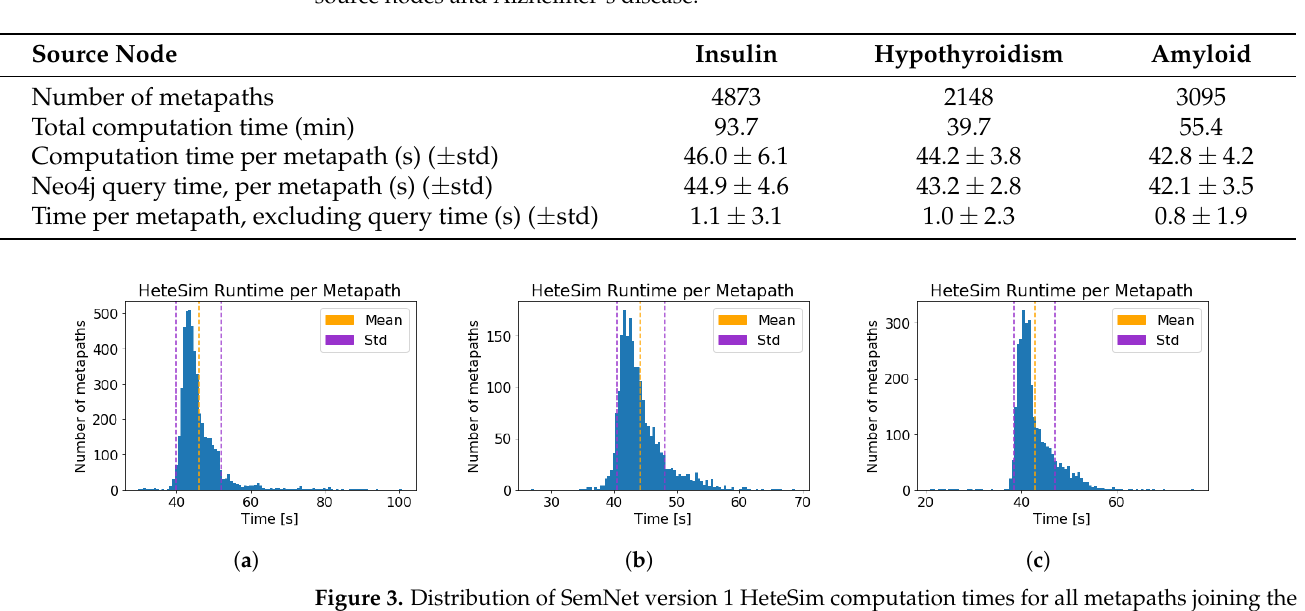
Table 1. SemNet version 1 HeteSim computation times for all metapaths between each of the three source nodes and Alzheimer’s disease.